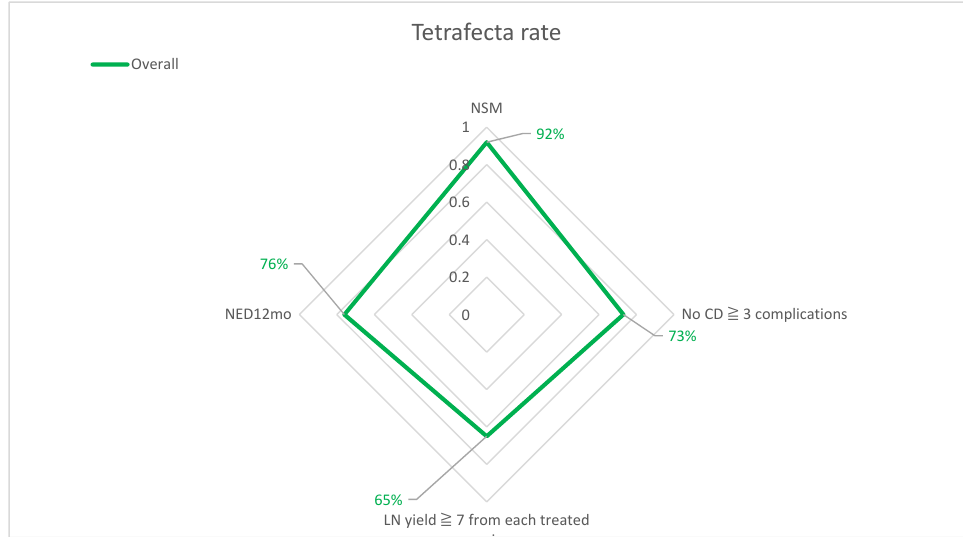
Figure 1. Surgical outcomes and Tetrafecta rate. Table 1. Patients’ characteristics and outcomes after PC surgery, according Tetrafecta achievement.